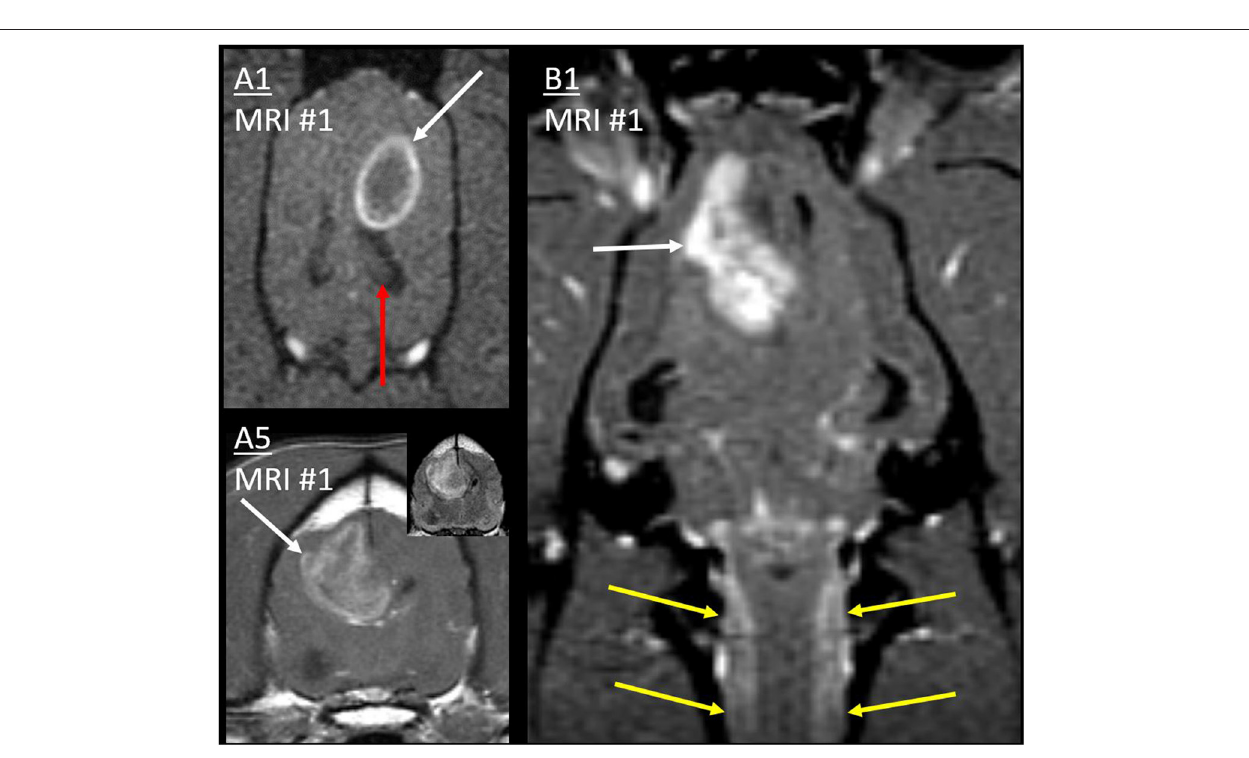
FIGURE 3 | Primary masses. Post-contrast T1W images of cases A1 and B1 (dorsal with fat saturation) and A5 (transverse). Primary masses (white arrows) showed strong, peripheral, or heterogeneous contrast enhancement. Inset: Mass in A5 was heterogeneous on T2W-FLAIR. In all three cases, the border of the primary mass made intimate contact with the lateral ventricle, resulting in ventricular displacement. In B1, thick cervical leptomeningeal enhancement (yellow arrows) results from type 1b diffuse leptomeningeal CSF drop metastasis. Normal ipsilateral hippocampus in A1 (red arrow) would be affected by metastasis much later ( Figure 9